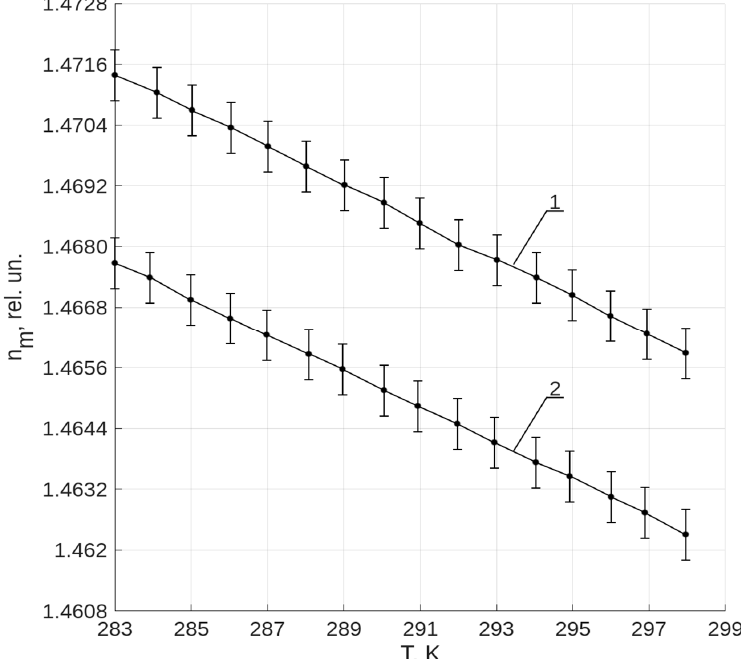
Figure 5. The dependence of the change in the refractive index n m of Rheinol PRIMUS PX 5W-30 motor oil from temperature T. The graphs correspond to the state of the motor oil: 1 is standard; 2 is the presence in the oil of gasoline of the AI-80 brand.